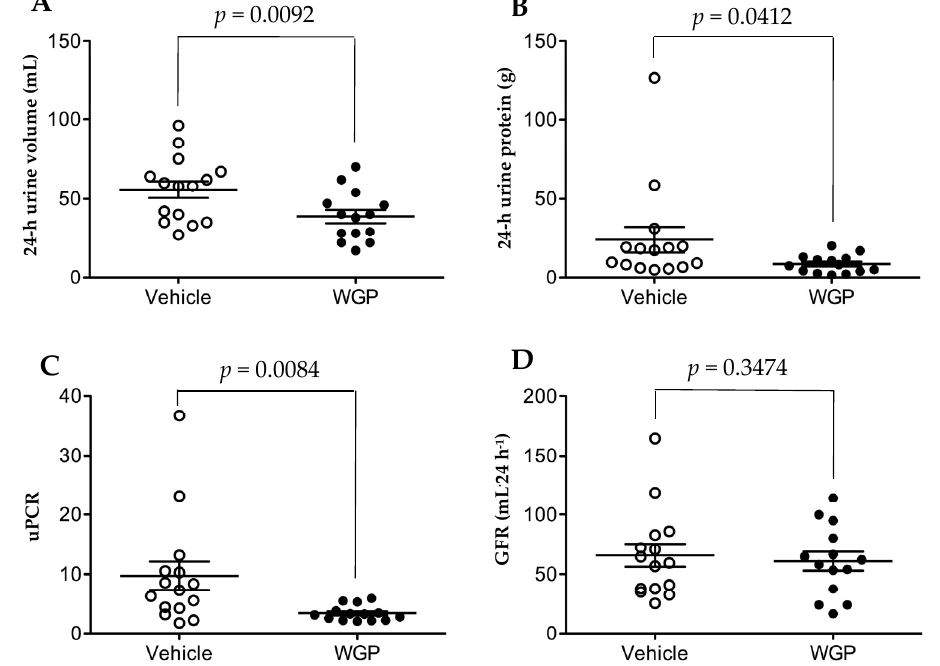
Figure 3. Daily intake of WGP reduces urine production and proteinuria but no effect on GFR in obese diabetic ZSF1 rats. A 24-h urine sample was collected from each rat in both Vehicle ( n = 15) and WGP ( n = 14) at the end of six months of dietary supplements. ( A ) Total volume of urine production from each rat during 24 h. Vehicle vs. WGP: p = 0.0092 (one-tailed t -test); ( B ) Total amount of protein in 24-h urine sample of each rat. Vehicle vs. WGP: p = 0.0412 (one-tailed t -test); ( C ) Protein to creatinine ratio (uPCR) in the urine sample of each rat. Vehicle vs. WGP: p = 0.0084 (one-tailed t -test); ( D ) GFR of each rat calculated based on creatinine clearance. Vehicle vs. WGP: p = 0.3474 (one-tailed t -test). Line: mean with the standard error of the mean (SEM).